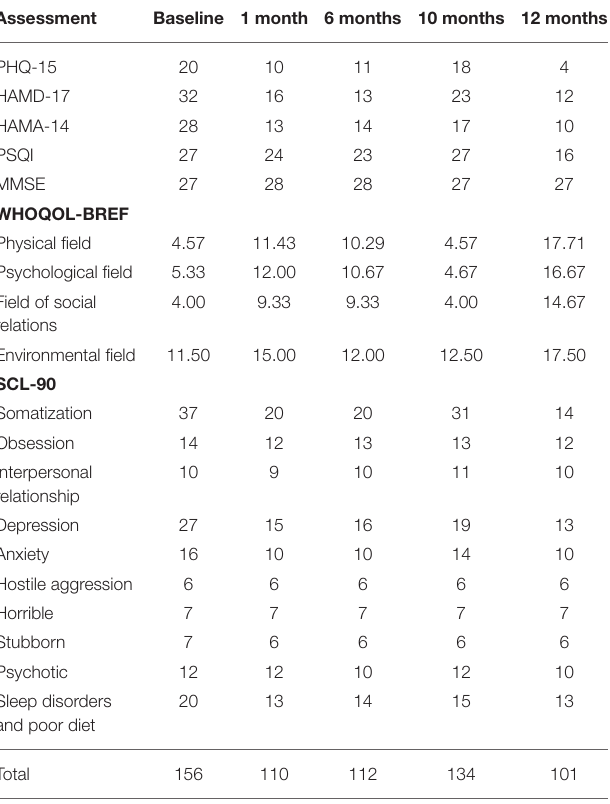
TABLE 1 | Assessment of the patient with SSD before and after bilateral capsulotomy. Assessment